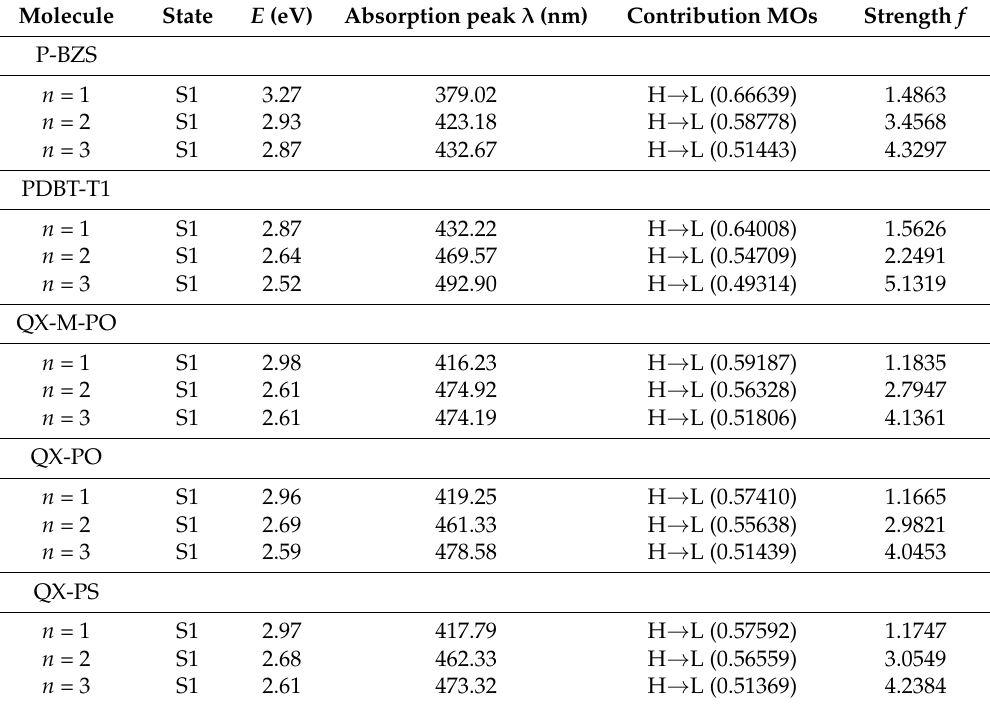
Table 6. The absorption peaks and corresponding oscillator strengths oligomers ( n =